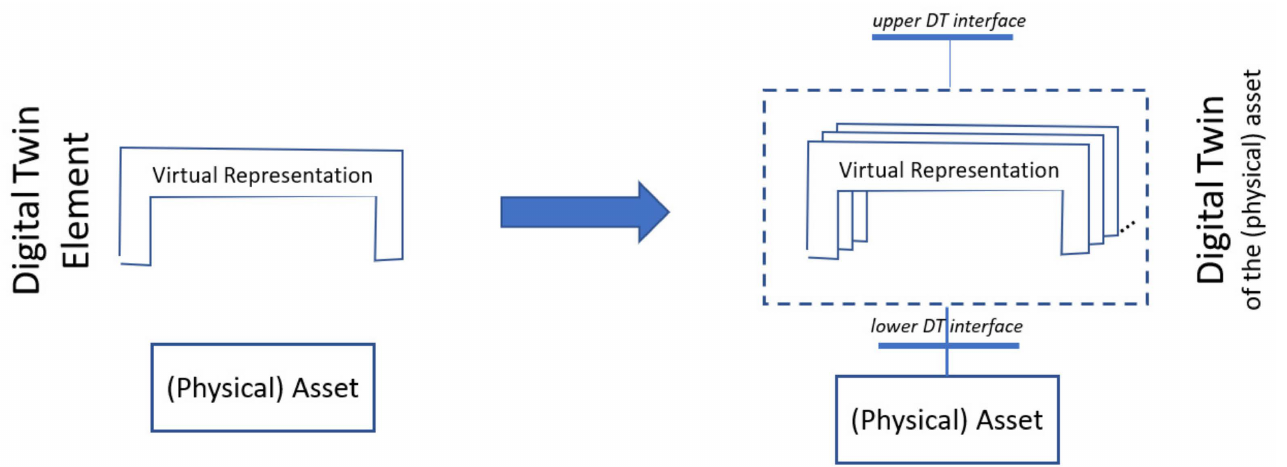
Figure 5. Digital Twin Elements forming a Digital